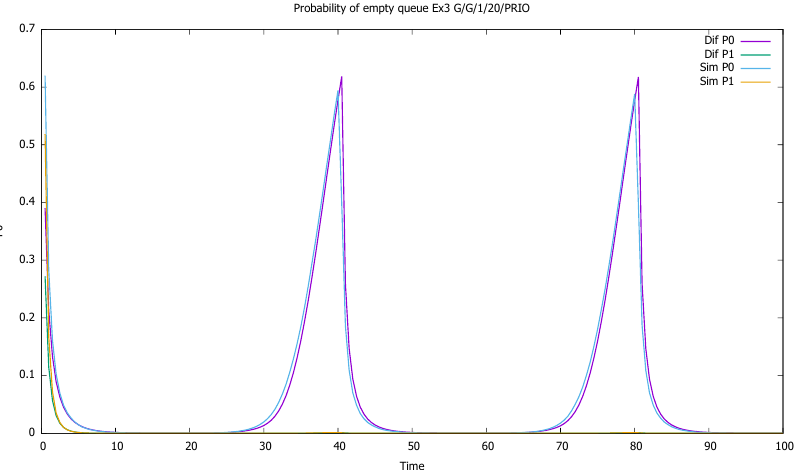
Figure 10. Section 3.3, high load: total mean queue length of both priority classes.